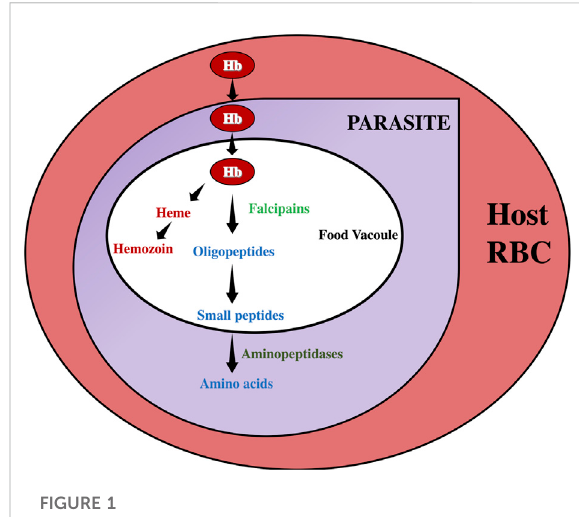
Simpli fi ed representation of hemoglobin catabolism in Plasmodium falciparum . Hemoglobin is denoted by